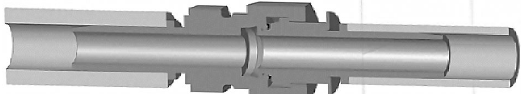
Figure 4. Cross-section cut in the HPH and DKOL fitting connection